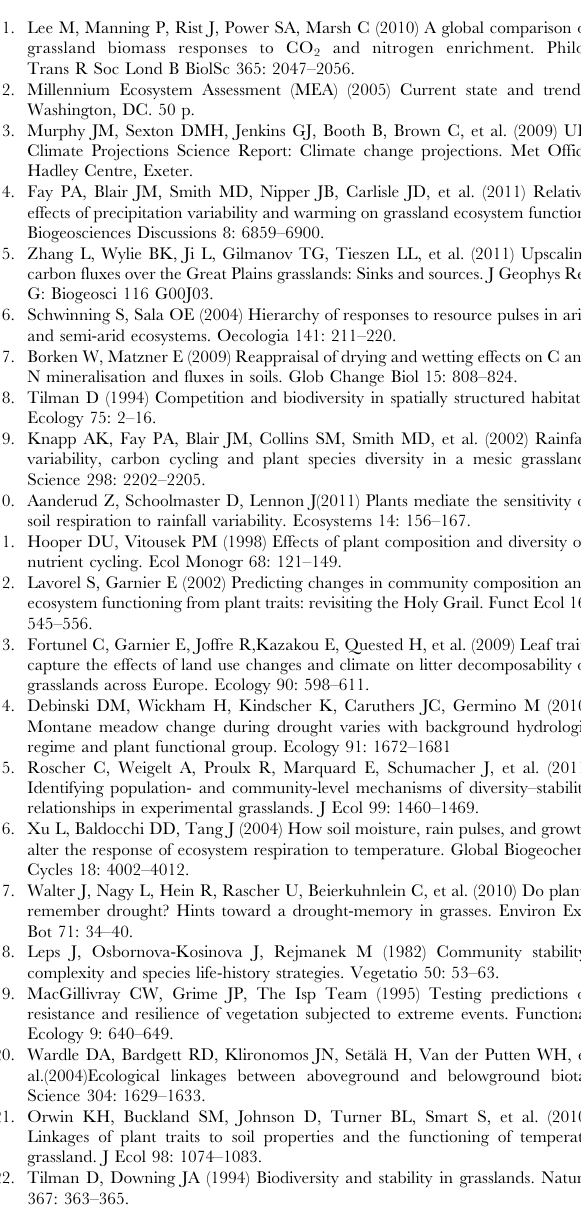
Figure S4 Effect of treatments upon H. mollis through- out the experiment. The FG in the legend refers to presence of these functional groups in the plots. Table S1 The list of the plant species in the field site in their allocated functional groups. Table S2 Percentage cover estimates of plots containing each functional group in turn at the beginning and end of the experiment. Due to overlap of species the values may exceed 100%. Table S3 Linear mixed effects model evaluating effect of treatments on H. mollis coverage over time. FGx refers